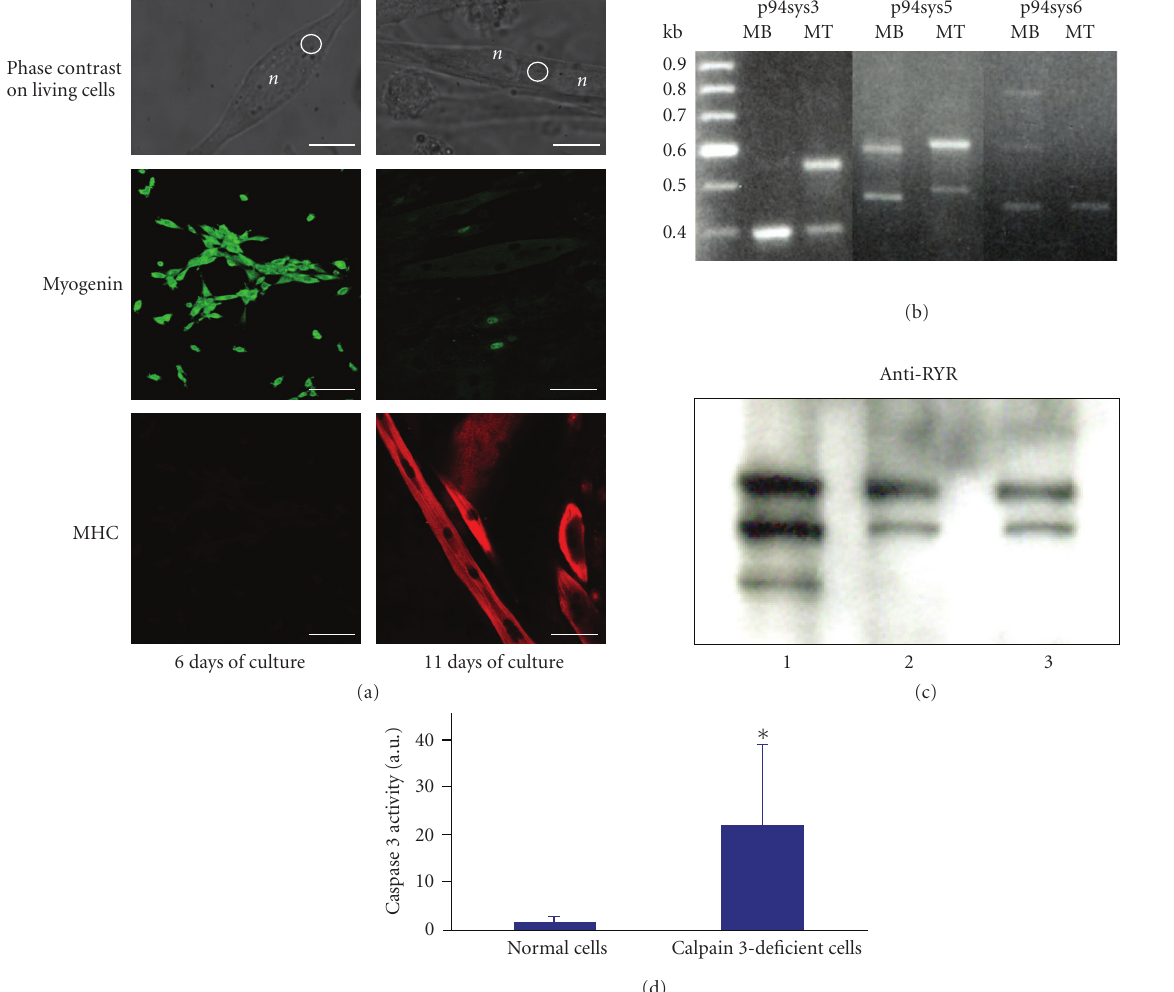
Figure 1: Morphological and molecular features of skeletal muscle cells used throughout this study. (a) Phase contrast and fluorescence micrographs of murine skeletal muscle cells in primary culture. Typical morphology of the living cells (left upper panel: myoblasts; right upper panel: myotubes) used for calcium measurements observed by phase contrast microscopy. Circles indicate the region of drug application and monitoring of [Ca 2+ ] i . Immunological staining of myogenin on myoblasts (left middle panel) and myotubes (right middle panel) was visualized by confocal microscopy using a FITC-labelled secondary antibody (green fluorescence). Myosine Heavy Chain (MHC) was similarly observed in myoblasts (left lower panel) and myotubes (right lower panel) using a TRITC-labelled secondary antibody (red fluorescence). Myoblasts and myotubes were obtained after 6 or 11 days in culture, respectively. (b) Detection of calpain 3-mRNA in wild type (+/+) myoblasts and myotubes by RT-PCR. Gel electrophoresis of the RT-PCR reactions obtained using the primer pairs p94sys3, p94sys5 and p94sys6 (see Section 2) on murine myoblast (MB) or myotube (MT) mRNA. (c) Detection of the ryanodine receptor in skeletal muscle from normal and capn3 -deficient mice. Muscle from normal (Lane 3) and capn3 -deficient mice (Lane 2) were extracted and left 30 min at room temperature to allow the cleavage of RyR and were then subjected to SDS-PAGE. Human muscle was used as control (Lane1). No di ff erence in the cleavage pattern was observed, indicating that the partial cleavage of RyR also occurs in the absence of calpain 3 in this biochemical assay. (d) Measurement of caspase 3 activity in wild type and capn3 -deficient myoblasts. The graph displays the levels of substrate cleavage expressed as means ± S.D. in arbitrary units. The results are based on 4 di ff erent experiments. The di ff erences in the median values among the two groups are greater than would be expected by chance; there is a statistically significant di ff erence ( P = 0 . 029), as indicated by a Mann-Whitney Rank Sum